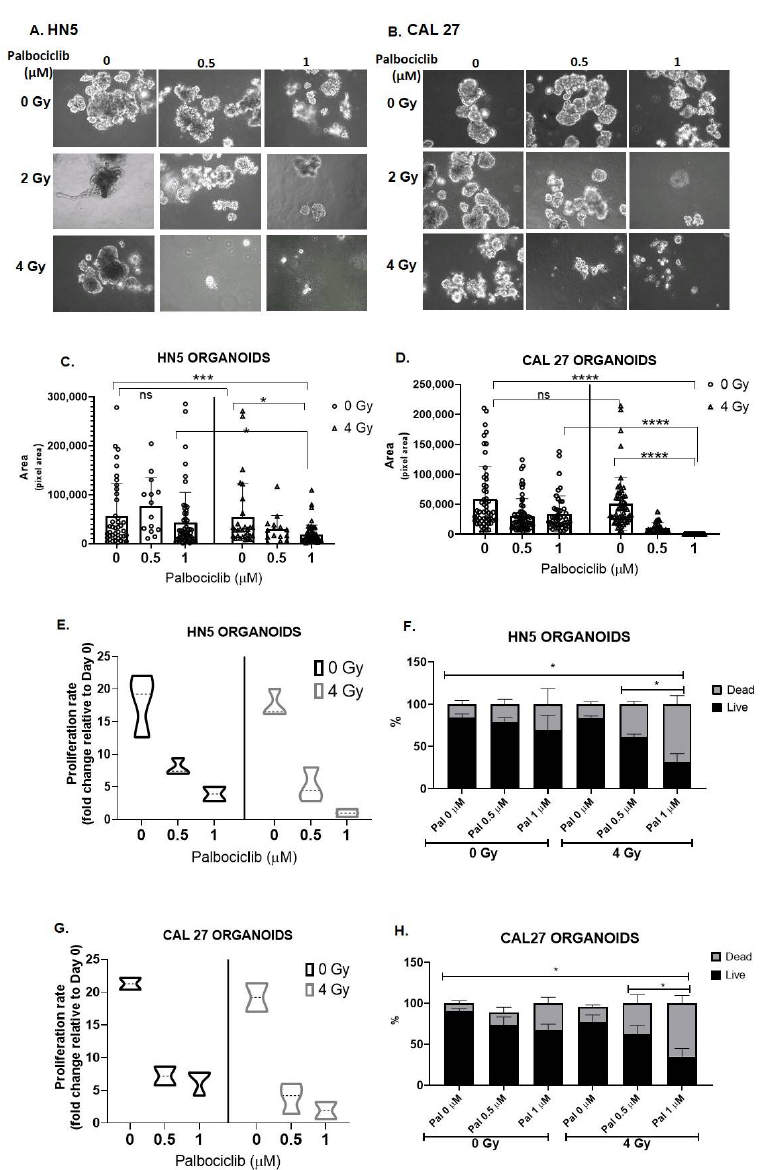
Figure 5. Palbociclib combined with RT results in decreased proliferation and increased cell death among HPV(−) OCSCC spheroids. HNSCC cells grown in 3D culture for 72 h in drug medium and radiation exhibits reduced spheroid formation and decreased spheroid size and viability in a dose-dependent fashion in HN5 ( A ) and CAL27 ( B ). Scale = 100 µm. Spheroid size was measured on day 12 by measuring pixel area of 50–100 random spheroids in Image J for HN5 ( C ) and CAL27 ( D ). Cell proliferation was calculated on the basis of total number of cells on the day of termination (day 12) relative to cells seeded on day 0 in HN5 ( E ) and CAL27 ( G ). Cell viability was evaluated by trypan blue assay on day 12 in HN5 ( F ) and CAL27 ( H ). The combination of palbociclib and RT demonstrated profound effects in both spheroid models. Analysis by one-way ANOVA. * p < 0.05; *** p < 0.005; **** p < 0.001. Each data point mean represents the average represented from three individual experiments. RT—radiation treatment; Pal—palbociclib;